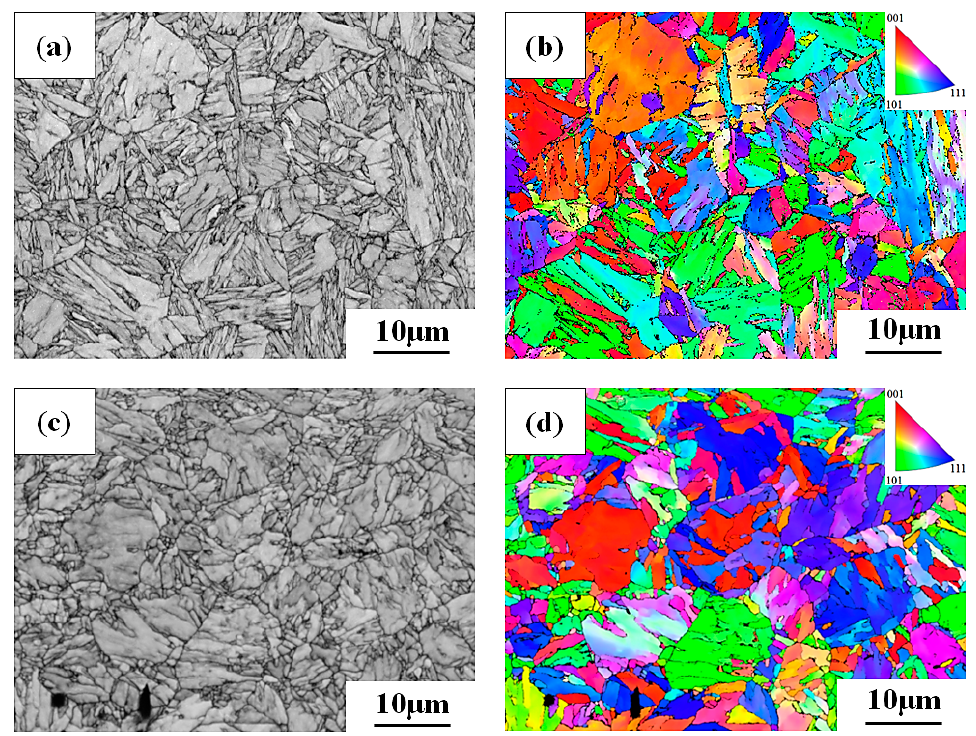
Figure 3. ( a ) SEM micrographs and ( b ) inverse pole figure (IPF) map of the 1060NT sample; ( c ) SEM micrograph and ( d ) IPF map of the 940NT sample.